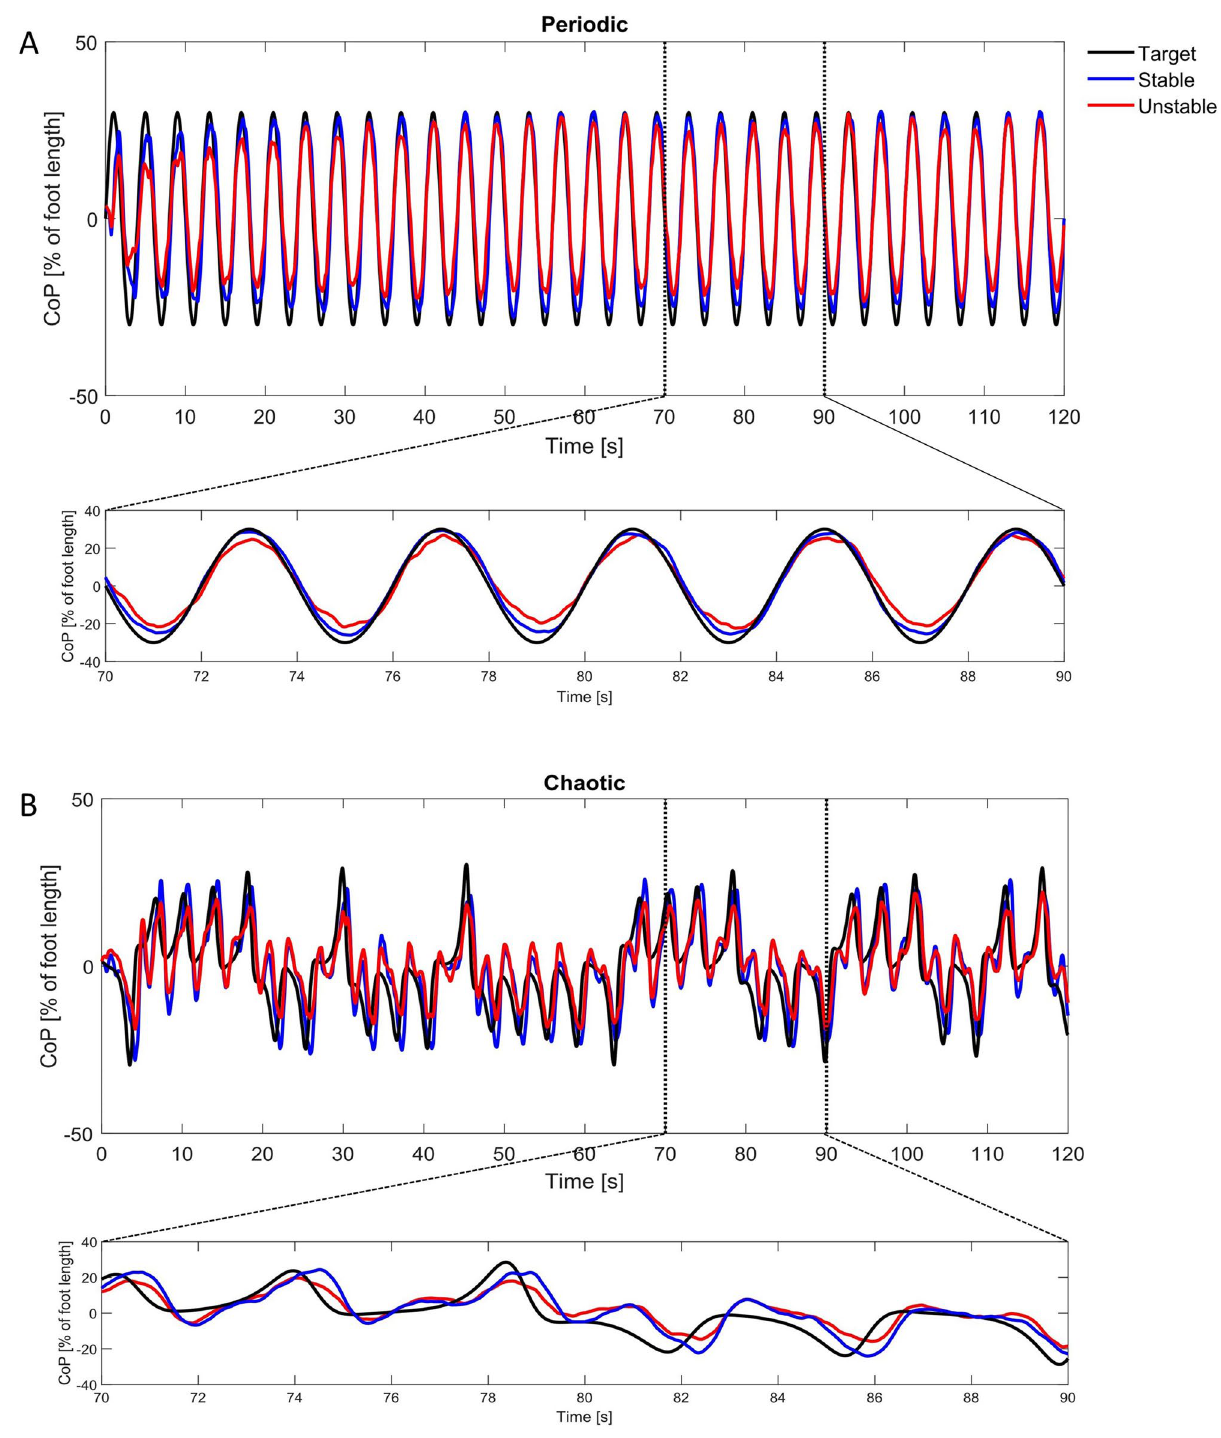
Figure 2. Target (in black) and grouped averaged values (n = 13) of CoP time series, during tracking the periodic-sinusoidal ( A ) and chaotic-Lorenz ( B ) moving target in sagittal plane on the stable (in blue) and unstable (in red) surface. The figure below provides a zoom in of the time window indicated by the vertical dashed found also an increase in system instability during walking, running 10 and continuous alternation from double-to single-leg standing 7 . Although, we cannot generalize this phenomenon in all kind of perturbations, it seems that in challenging perturbed conditions the instability is increased. There are reports that mechanical noise applied to the feet via vibrating insoles improves balance performance during quiet-stance 46,47 . However, the induced mechanical perturbations using vibrating insoles are quite minor compared to all our perturbed conditions,